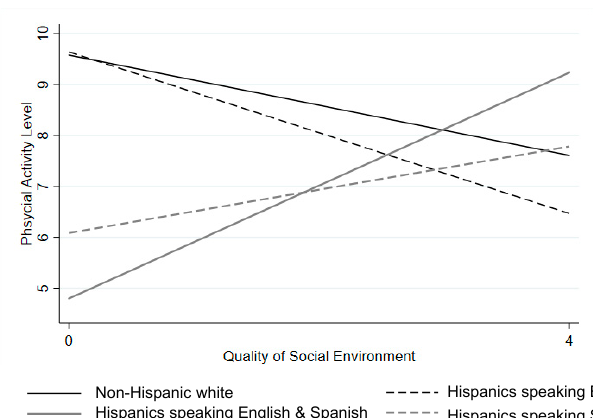
Figure 1. Predicted physical activity associated with the social environment by child language at home, as shown in Table 3, Model 3, setting all other variables within the model at their average value. Note. The social environment was measured based on a four-item scale on neighborhood safety, traffic, and crime. Higher scores indicate higher quality social environment.